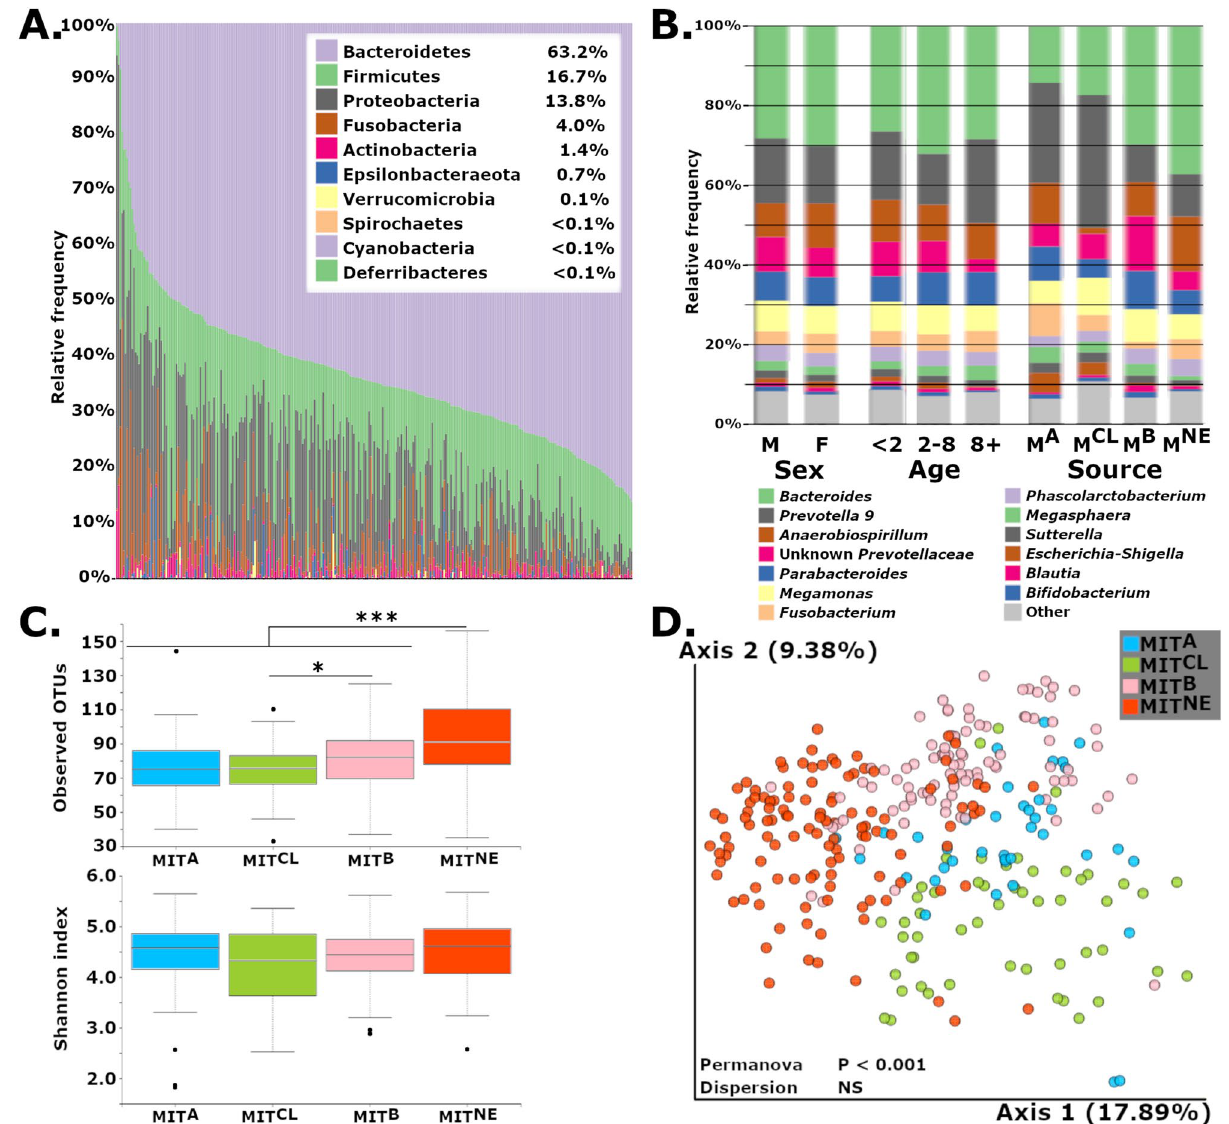
Figure 1. ( A ) Gut microbiome profiles of healthy, common marmosets at the phylum level exhibit a Bacteroidetes-dominant and human-like microbiome. ( B ) Averaged relative abundances at the genus level show differences associated with source but few differences based on sex or age. ( C ) Observed OTUs were increased in MIT NE vs. all sources, and MIT B vs. MIT A and MIT CL , but metrics involving evenness, such as Shannon’s diversity index, showed no difference. Boxplots encompass the 25th and 75th percentiles of the distribution with the horizontal bar representing the median. *P < 0.05; ** P < 0.01 and *** P < 0.001. ( D ) PCoA plot using Unweighted UniFrac metric shows clustering of microbiome profiles based on marmoset